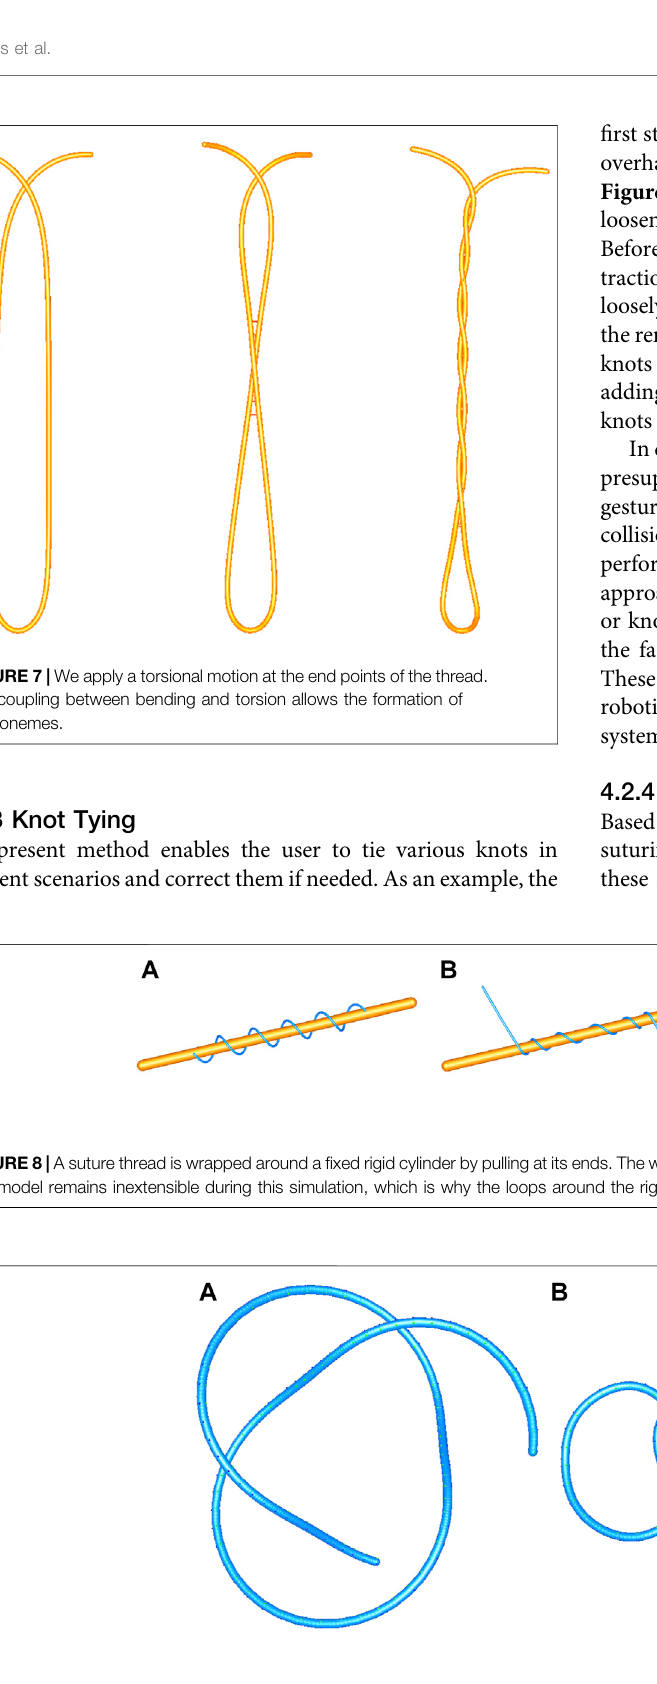
FIGURE 9 | Gradual tightening of a simple knot. The motion is sampled at time 0 [ s ] ( A ) , 1 [ s ] ( B ) , and 2 [ s ] ( C ) . The accurate contact model allows to form the knot and to tighten it.